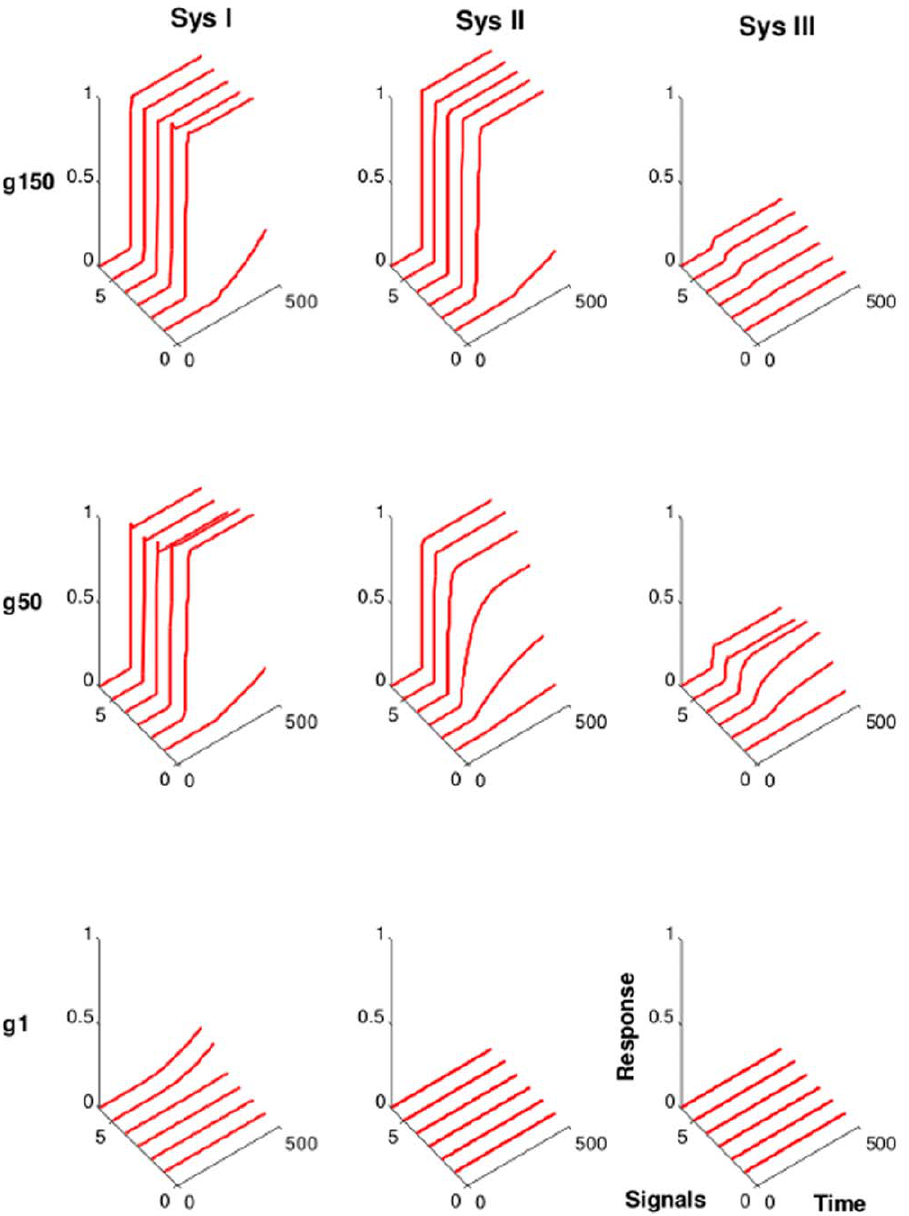
Figure 4. Kinetics of the evolved networks. Shown are the networks with the highest fitness score from one of the simulation runs. g 1 , g 50 , and g 150 denote the generation 1 , 50 , and 150 , respectively. The six solid lines show the kinetics of activation of the output node in response to six different input signal strengths (strength increases with signal index). Signals are provided at time t ~ 150 . Sys I, weak interactions ( k v 10 ). Sys II, moderate interactions ( k v 30 ). Sys III, strong interactions ( k w 30 ).